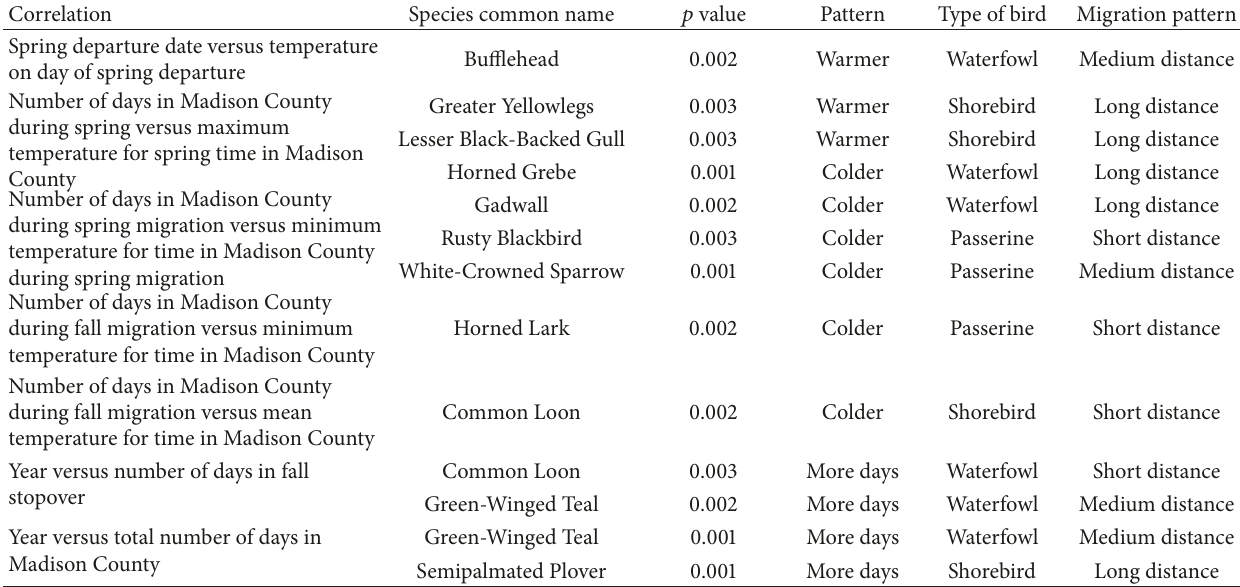
Table 2: Migration timing changes and significant environmental temperature changes experienced by species showing a two-stopover migration strategy through Madison County. Migration patterns were determined using data from the Cornell lab of ornithology and Zuckerberg et al.